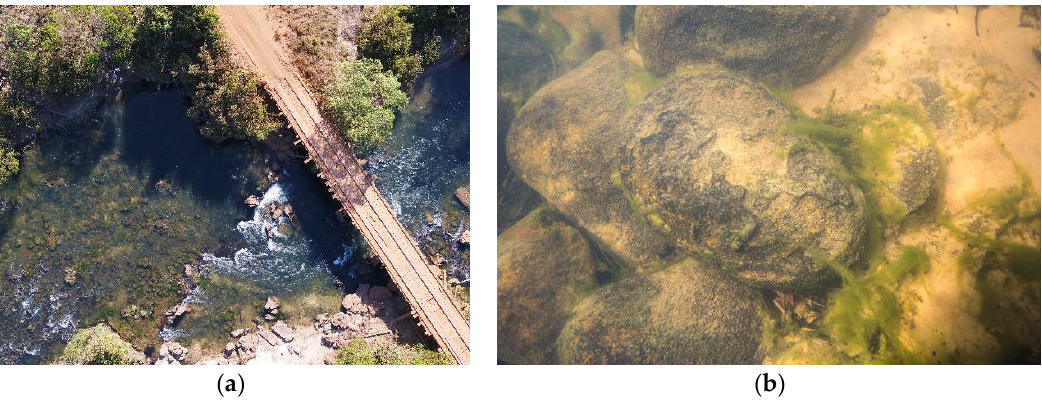
Figure 5. ( a ) Example of a UAV photograph acquired from 30 m altitude at the Jatobá site used in the SfM-MVS analyses. ( b ) Example of an underwater photograph collected with the camera housing at the water surface (Jatobá) and the lens facing nadir (Scale not